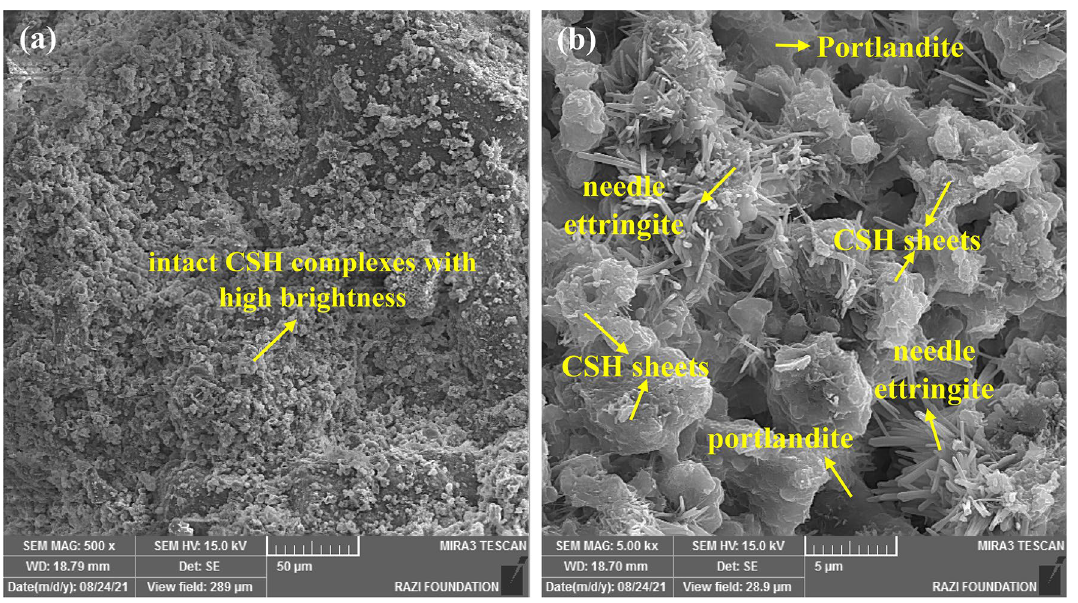
Fig. 13 The scanning electron microscope (SEM) images of intact mixture with 10% cement and no F-T cycle: a 500× magnification, b 5000×